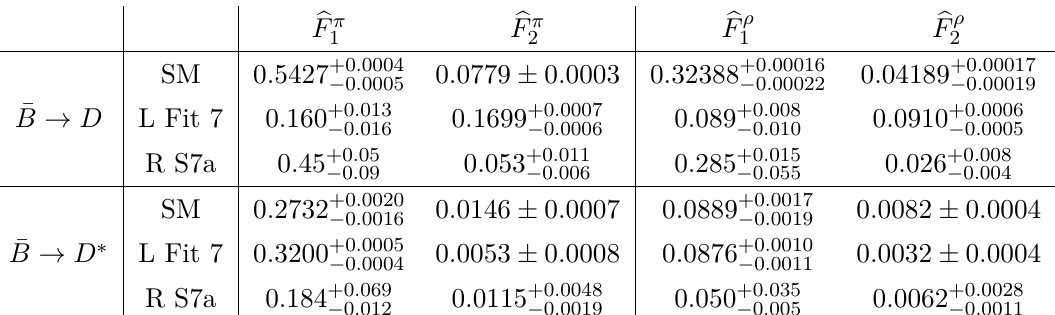
for the ¯ B → D ( ∗ ) τ ( πν τ , ρν τ )¯ ν τ decays evaluated 1 , 2